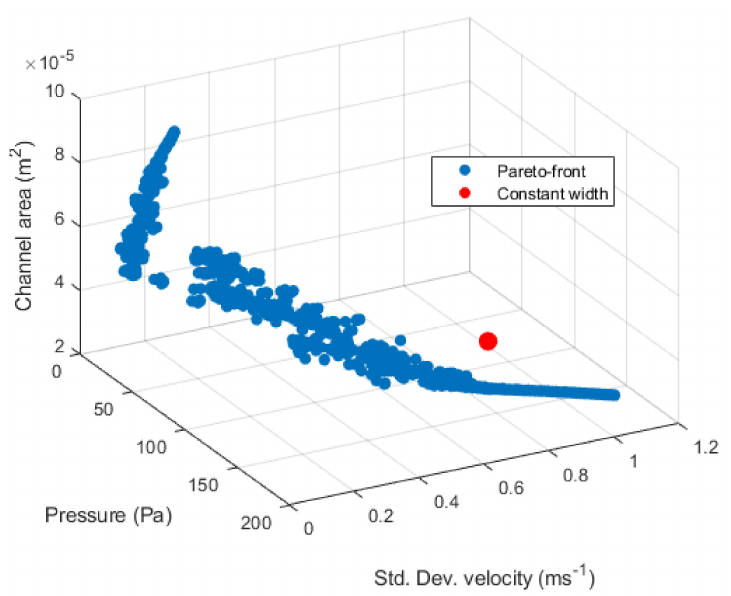
Figure 9. Pareto-front of 3 × 3 flow field along with dominated solution of constant channel widths (0.6 mm).